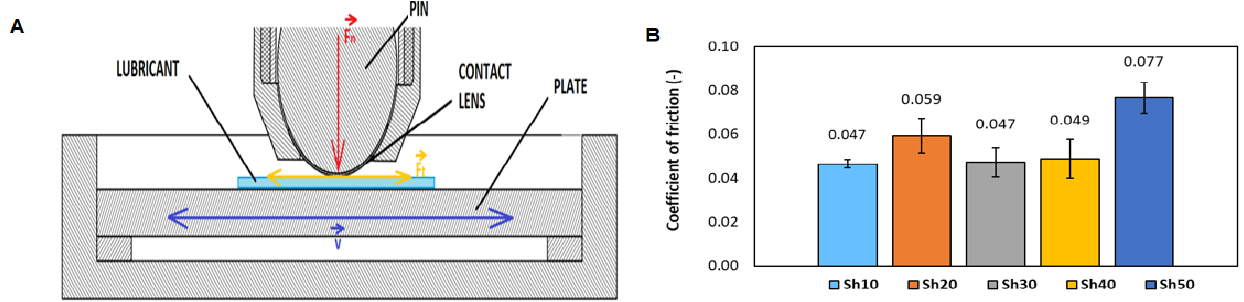
Figure 3. ( A ) Pin-on-plate configuration used in this work ( B ) The average friction coefficient of different silicone ball- hardness at normal force 1 N.